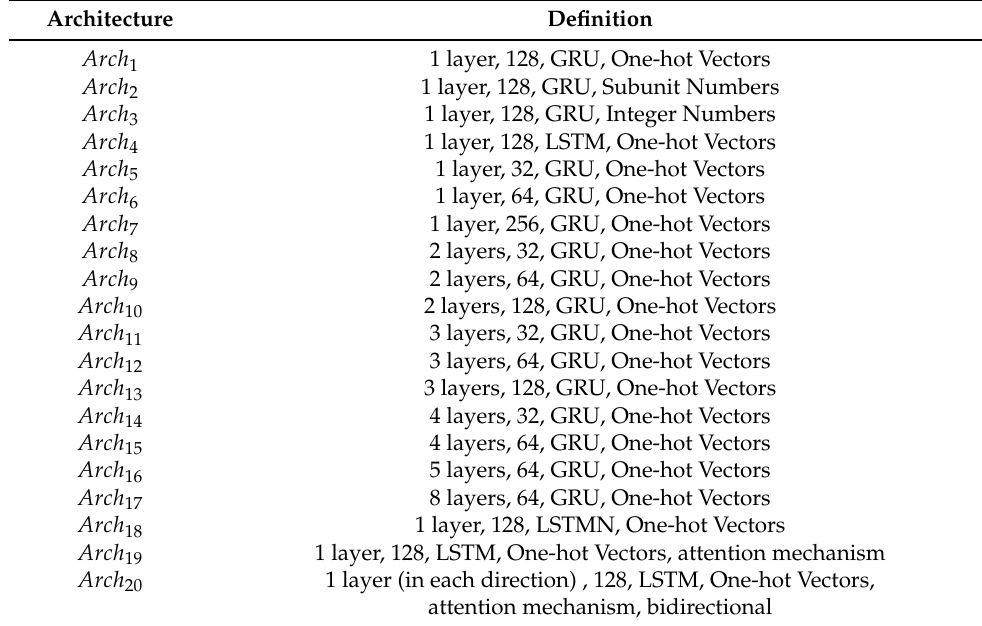
Table 3. Tested RNN architectures for the proposed